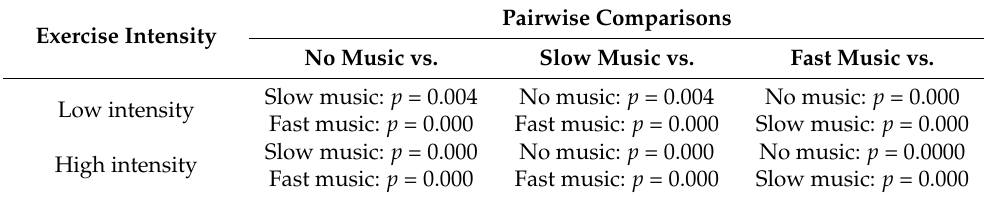
Table 5. Post hoc test of TFP under different experimental